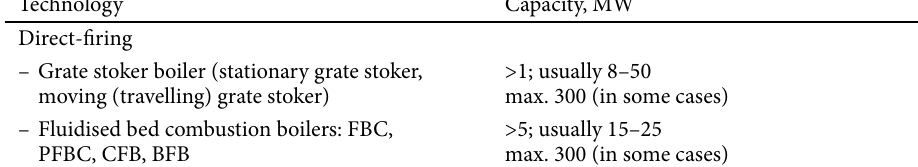
Table 2. Capacity range for wood biomass combustion technologies intended to heat and power production Technology Capacity,